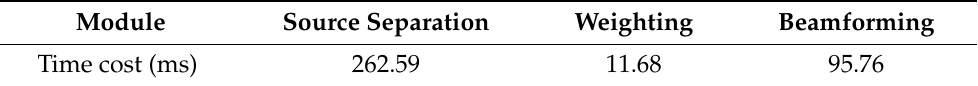
Table 1. Computational time cost in ms for each